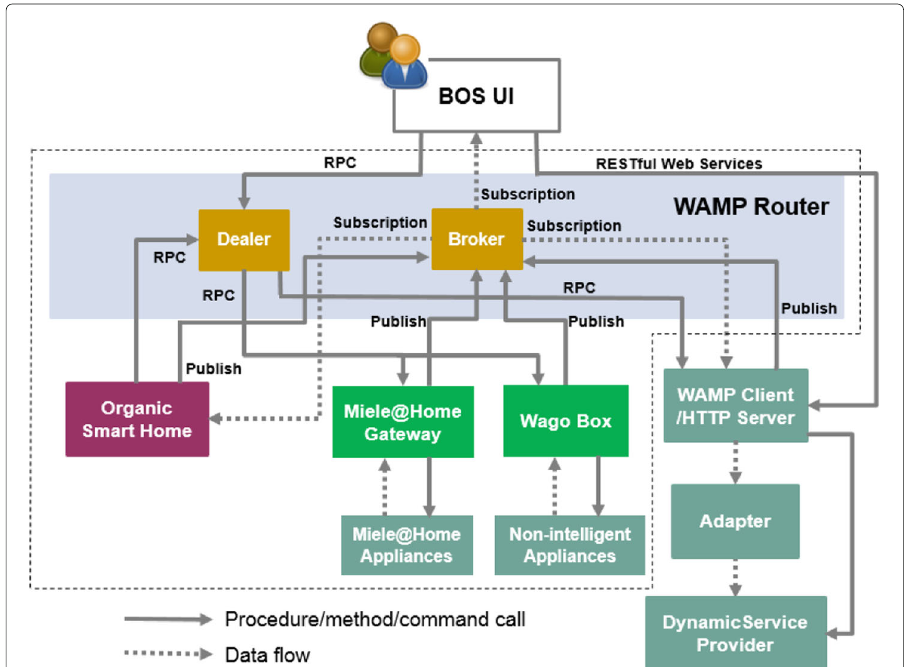
Fig. 10 The communication between the BOS UI, the OSH, the devices in the ESHL via a WAMP router